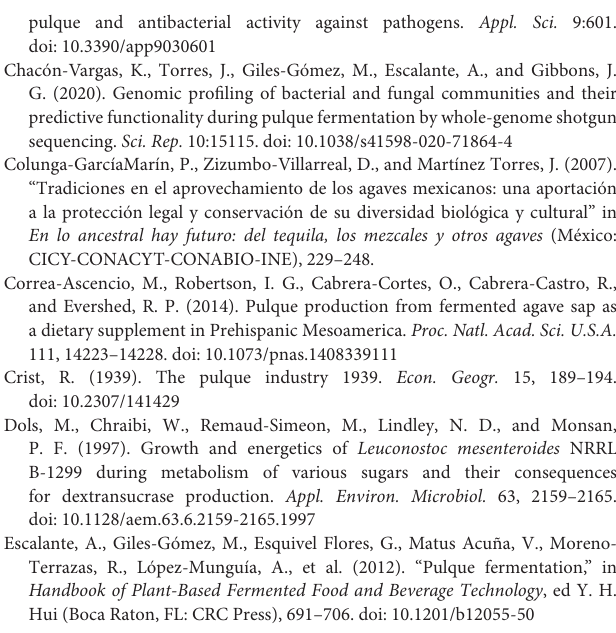
Supplementary Figure 1 | Pulque castration process. The tlachiquero selects the proper mature plants on the basis of the thinness of the central leaves (heart or meloyote ). (A) The tlachiquero uses a sharpened knife to cut off some leaves surrounding the heart. (B,C) Cutting of the heart. (D–F) Destruction and extraction of the remaining floral bud with a sharpened pray bar. (G) Scraping of the wall of the resulting cavity with a scraping tool or raspador to shape the final size of the cajete. (H) Once the cavity was completed, it is covered with leaves to start the maturation process. Images kindly provided by Mrs. E. Velázquez Gutiérrez. Supplementary Figure 2 | The cycle of life of maguey for pulque production. (A) Seedling, (b) adult plant, (c) flowering, (d) flower, (e) seeds, (f) bulblet, and (g) stolon. Sexual reproduction by seeds resulting from pollination of the inflorescence (c–e, a). Vegetative propagation from bulblets (f) or by transplanting stoloniferous shoots or hijuelos of the mother plant (g). (B) Vegetative propagation by transplanting stoloniferous shoots of 1-year-old and a height of 50–60cm (a) are transplanted to a greenhouse. Young plants are transplanted to the field when they reach 1m in height or are 1–2 years old (b) to complete its growth for aguamiel production (c) ( García Mendoza, 2007; Nieto Aquino et al., 2016; Álvarez-Ríos et al., 2020). Supplementary Figure 3 | Main products obtained from the maguey, aguamiel, and pulque. Gualumbos, mixiote, maguey worms, and leaves ( pencas ) are used